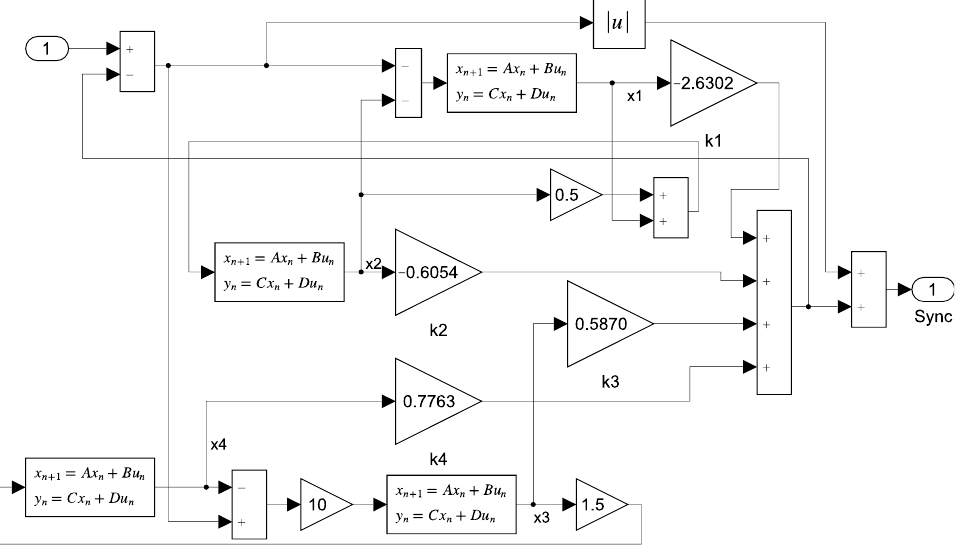
Figure 8. Implementation of the chaotic generator and synchronization circuit in the ACSK